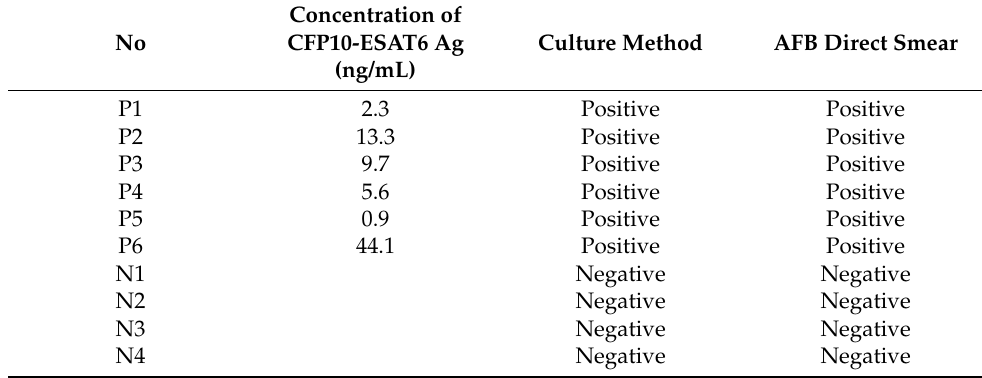
Figure 6. Current measured using portable reader from 10 clinical sputum samples immobilized on aptasensor. The results were identified as six positive (P) samples and four negative (N) samples, in accordance with the culture method. Table 2. Comparison of various TB results from the culture method, smear microscopy, and portable aptasensor reader.